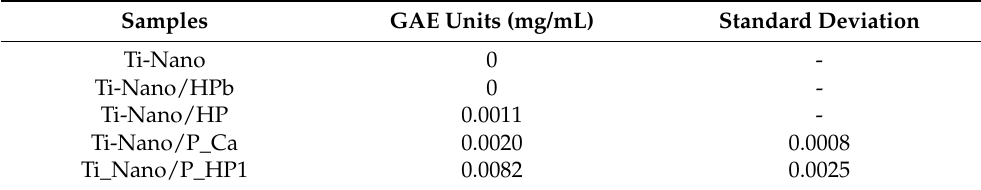
Table 4. Content of total polyphenols on the samples (Folin–Cioc â lteu